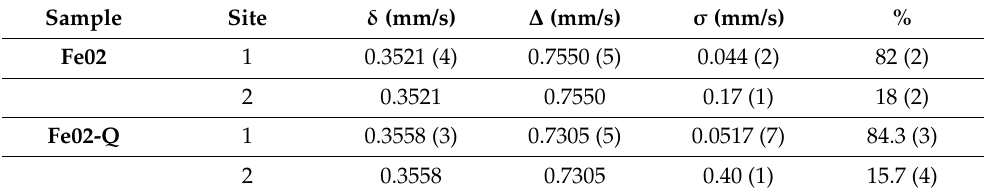
Table 3. The 57 Fe Mössbauer parameters, extracted from the fit of the spectra: isomer shift with respect to α -Fe ( δ ) and quadrupole splitting ( ∆ ). Parameters with no errors were kept fixed in the fitting procedure. The relative weight of each contribution is also reported.